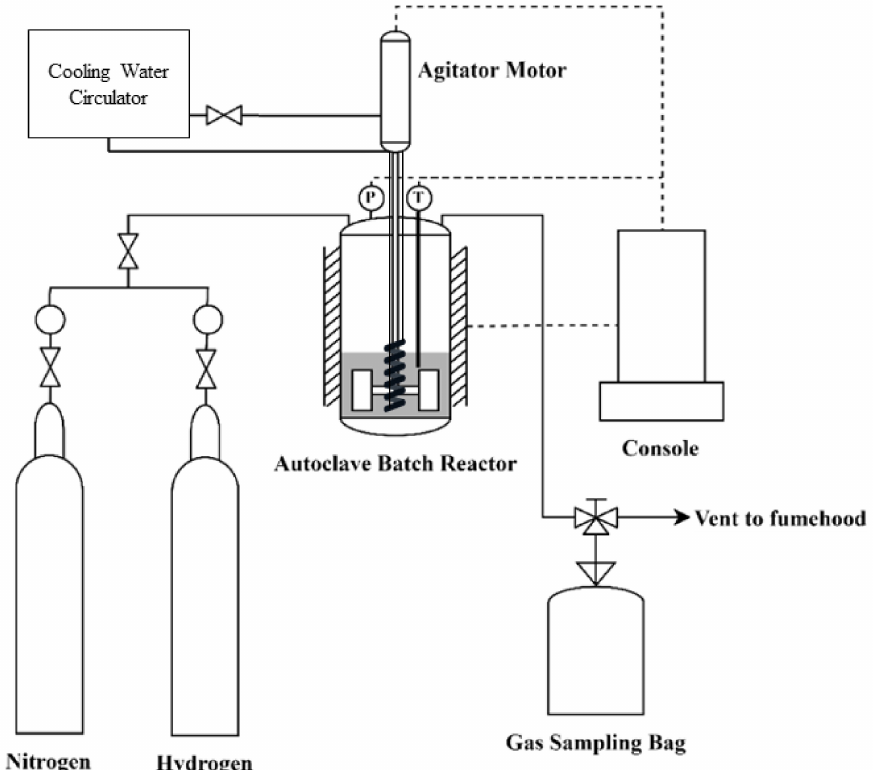
Figure 6. Schematic of the autoclave batch reactor used for the hydrocracking of VGO experiments. Products